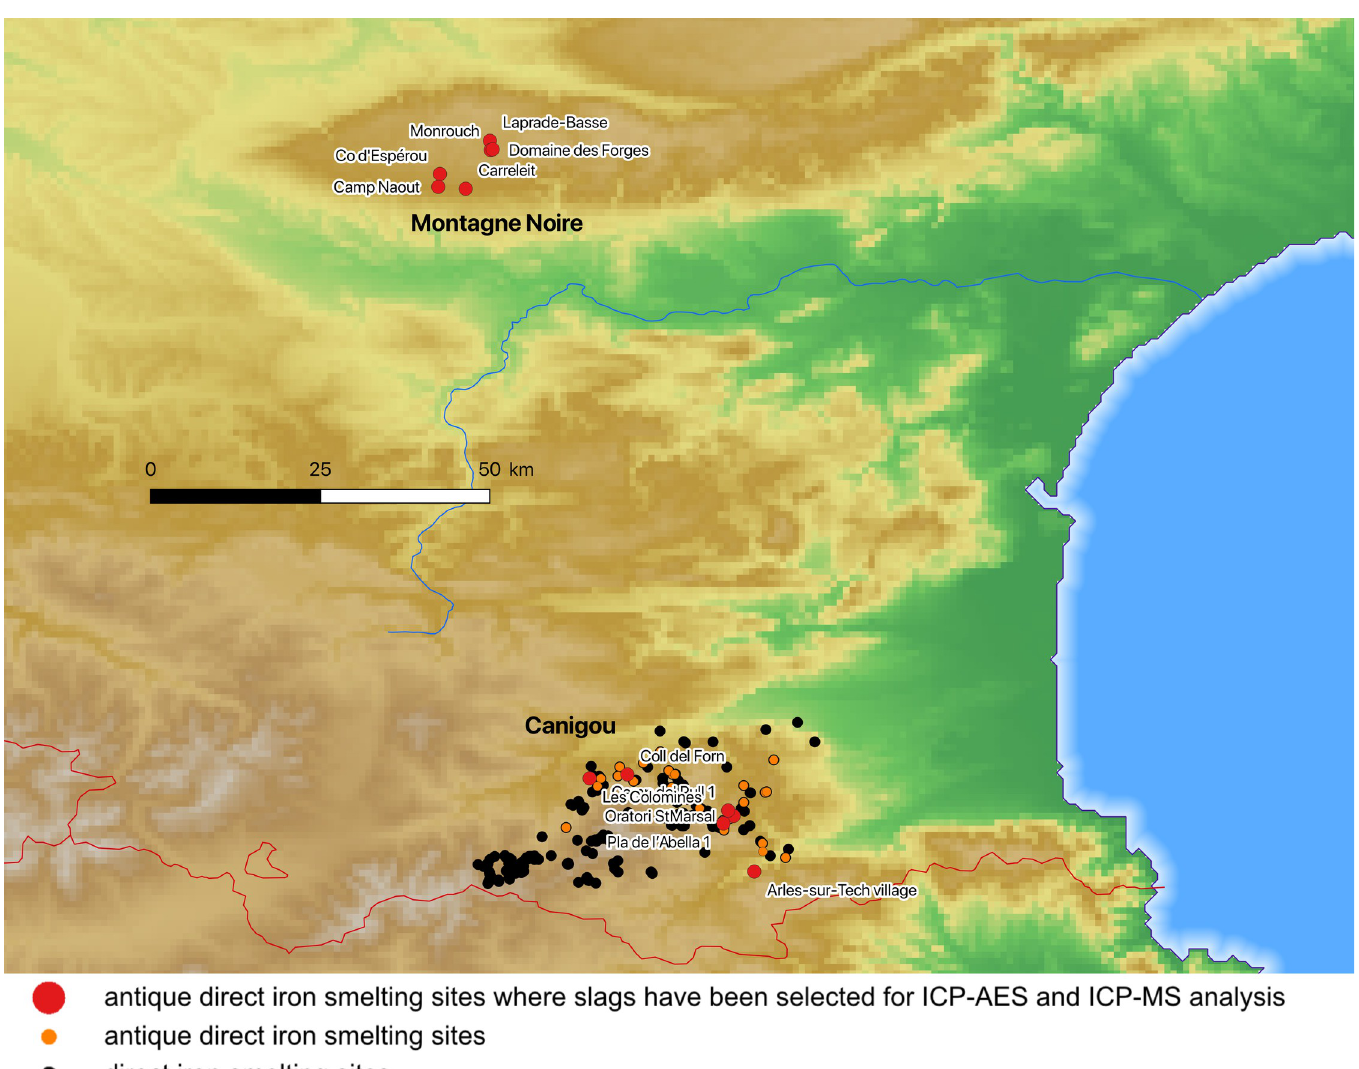
Fig 6. The Montagne Noire and Canigou iron production areas (north at the top; DEM NASA Shuttle Radar Topography Mission Global 1 arc second).